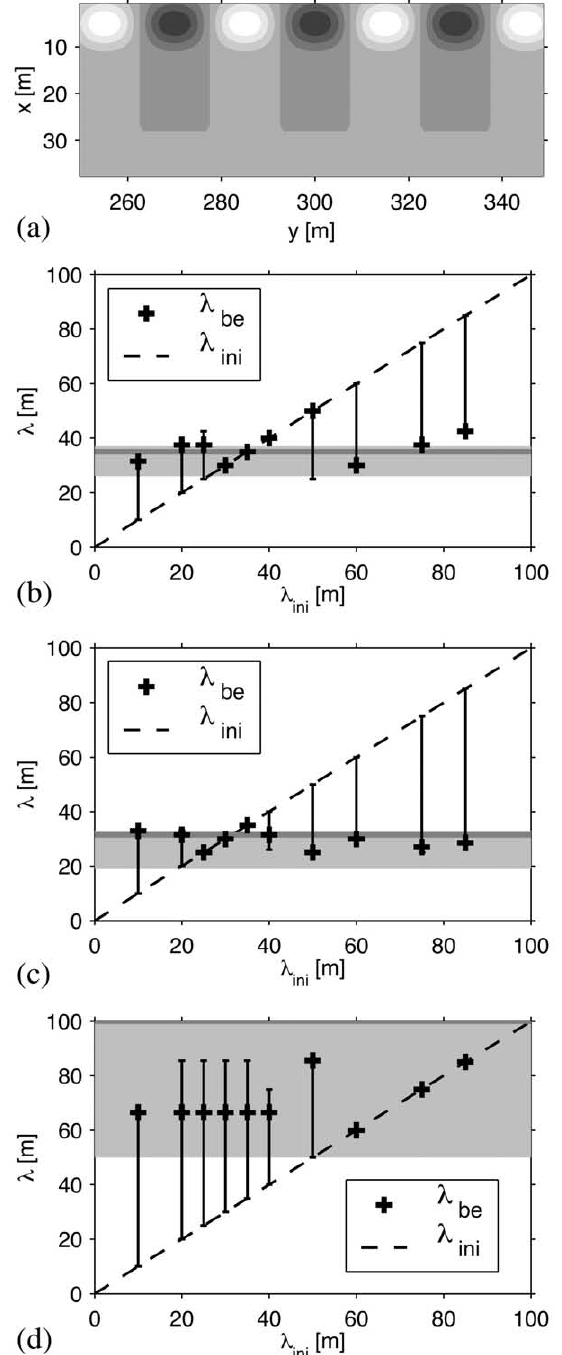
Fig . 10. – (a) Initial bed level perturbation (h), for λ =30 m. ini (b-d) Influence of the preexisting cusp wavelength on the final wavelength. (b) Transverse bars (SVR sediment transport, θ 0 =0), (c) Down-current oblique bars (SVR sediment transport, θ 0 =10°), and (d) Up-current oblique bars (CWS sediment transport, θ 0 =10°). Plus-symbol (+), wavelength at the equilibrium state ( λ ) as a func- be tion of the preexisting wavelength ( λ ). Vertical line (error bar), ini range of wavelength λ as a function of λ . Dashed line, slope 1:1 b ini line. Grey horizontal line, equilibrium wavelength λ obtained from be free instability (Table 3). Grey surface, range of wavelength λ b